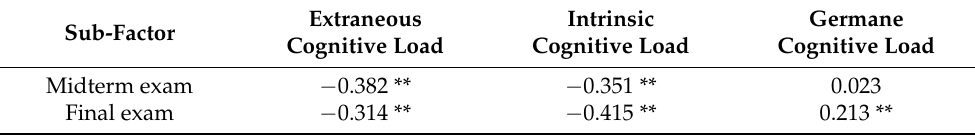
Table 5. Correlation with midterm and final exam scores.